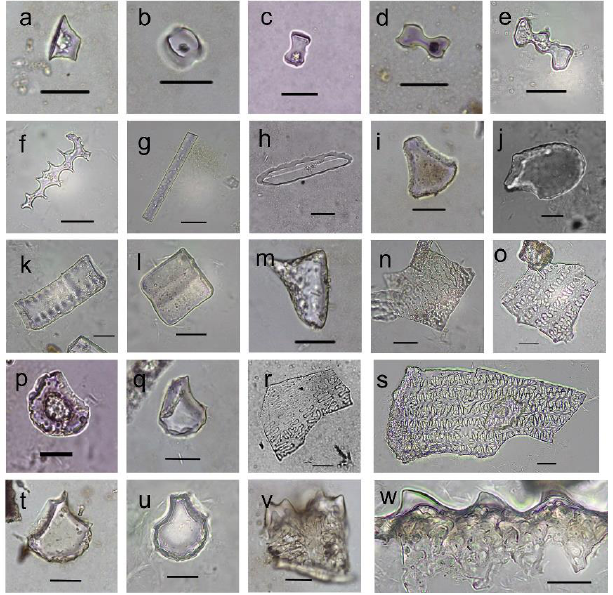
Figure 3. Phytoliths obtained from samples collected at Zhangwangzhuang: ( a ) Rondel; ( b ) short saddle; ( c ) long saddle; ( d ) bilobate; ( e ) multilobate; ( f ) sinuate elongate; ( g ) smooth elongate; ( h ) trapeziform sinuate; ( i ) bulliform; ( j ) reed bulliform; ( k ) rectangle; ( l ) square; ( m ) acicular hair cell; ( n ) barnyard grass; ( o ) foxtail millet; ( p ) rice bulliform without countable and clear fish-scale deco- rations; ( q ) rice bulliform with <9 fish-scale decorations; ( r , s ) broomcorn millet husk; ( t , u ) rice bul- liform with ≥9 fish -scale decorations; ( v , w ) rice double-peaked (scale bar = 20 μm) .